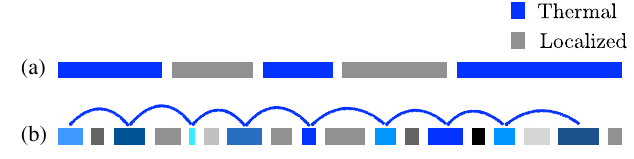
FIG. 6. Schematic depiction of two possible models of the crossover from the MBL phase to the thermal phase. (a) The picture from VHA ’ s RG [22] predicts contiguous thermal or localized blocks. At the crossover, a few long thermal blocks occupy a finite fraction of the system, giving a subthermal but volume-law half-chain EE. (b) An alternate picture for the transition with a sparse entangled backbone of small thermal blocks of spins with varying degrees of entanglement. The backbone is not contiguous but spans the entire system, and the thin blue lines denote entanglement between the blocks. In both pictures, the thermal clusters acquire just enough strength to thermalize the entire system on the thermal side of the transition in the limit L → ∞